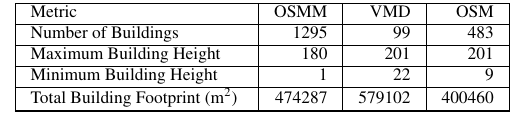
Table 1: Dataset Comparison